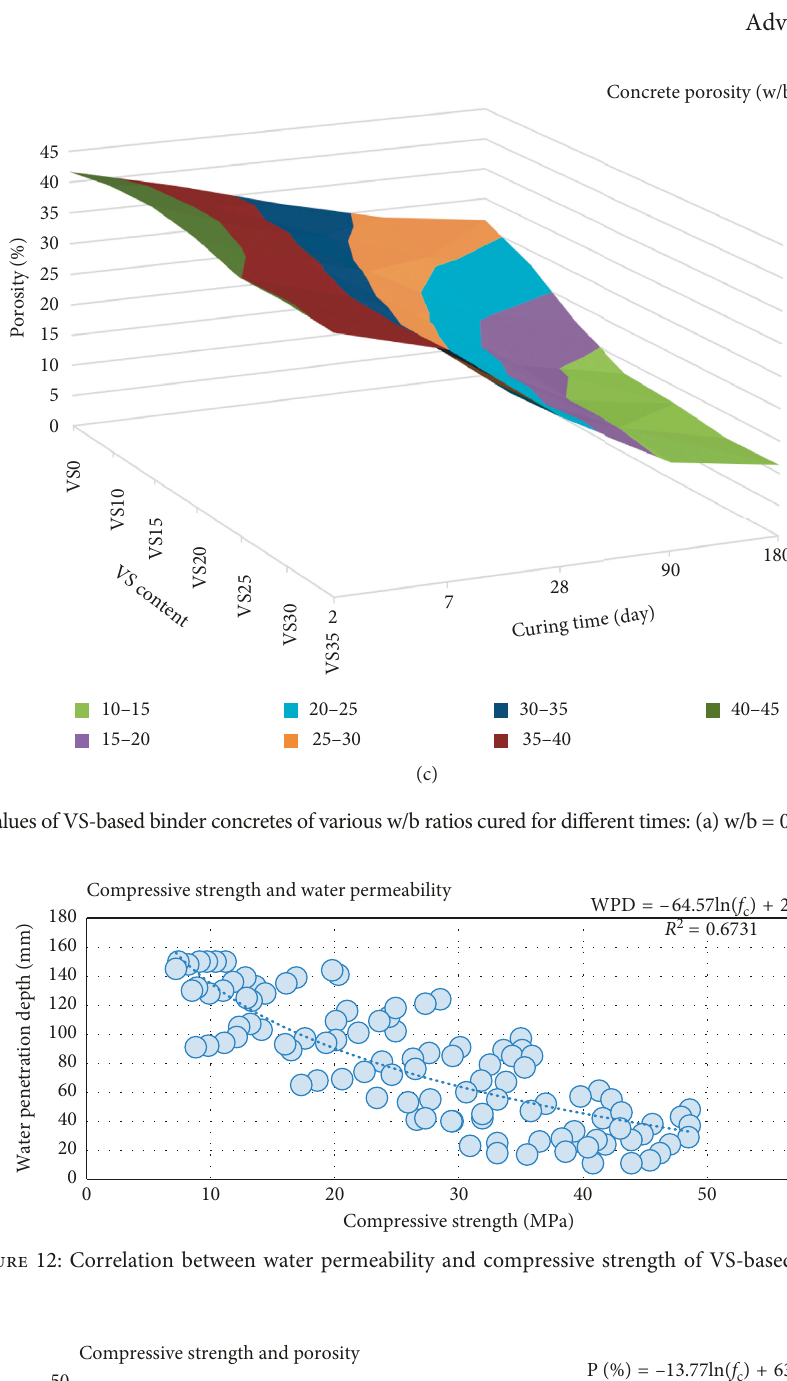
P (%) = –13.77ln( f c ) + 63.016 R 2 = 0.516